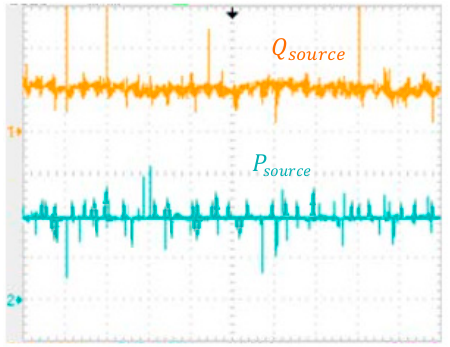
Figure 8. Experimental results for average reactive power compensation [VA/div: 1000 VA and time/div: 10 ms].